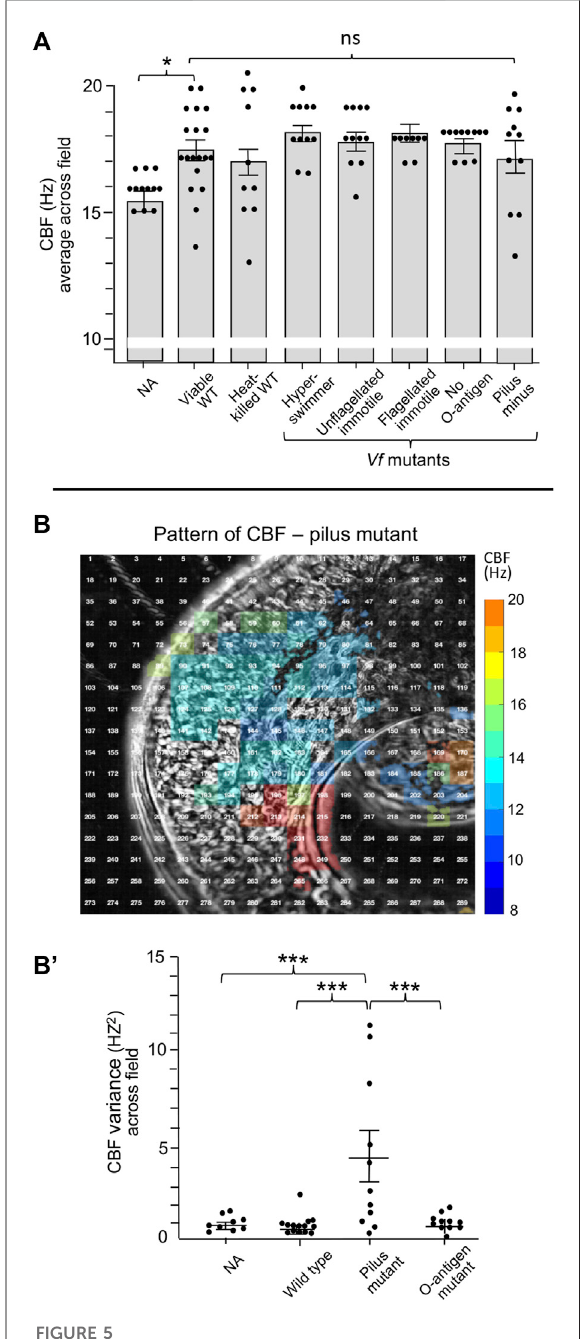
FIGURE 5 Ciliary beat frequency (CBF) measurements of hatchling light organs show no effect of symbiont viability or certain surface features or behaviors. (A) Conditions and features that show no difference in CBF and pattern of CBF in comparison with exposure to viable wild-type V. fi scheri . In all conditions,